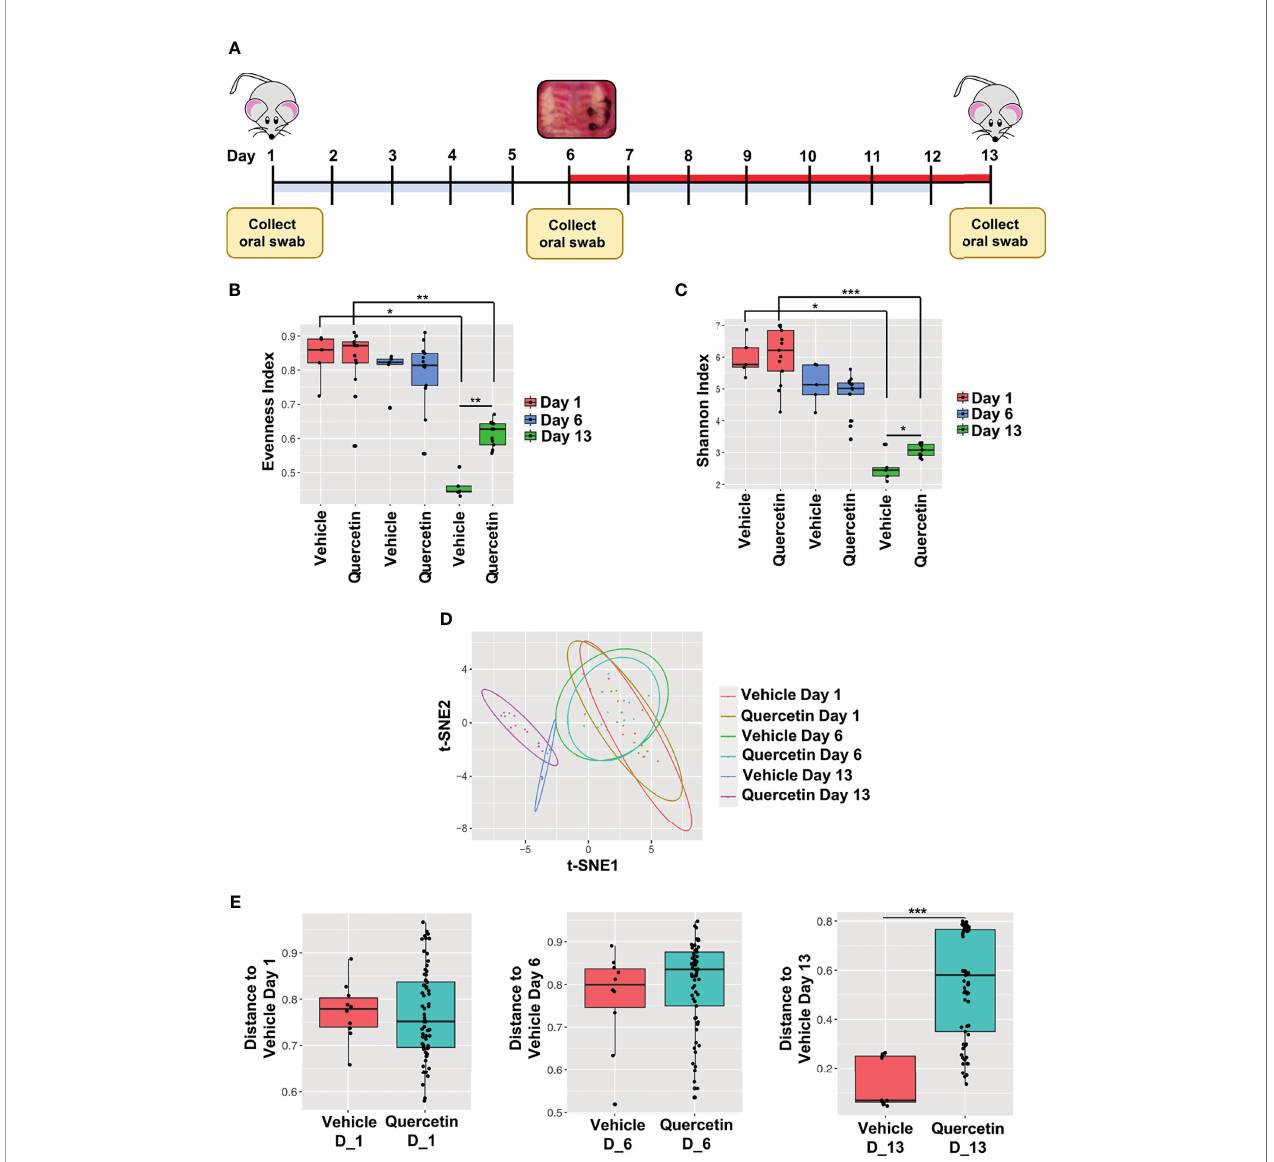
FIGURE 2 | Quercetin Treatment Increases Bacterial Diversity in Mice with Experimental Periodontitis. (A) Schematic diagram illustrating the periodontal induction and treatment experimental design and timeline of oral swab collection for subsequent 16S rRNA sequencing microbiome analysis. (B, C) Alpha diversity was assessed in the oral microbiota of 5 vehicle- and 13 Quercetin-treated mice before and after the induction of periodontitis and the Evenness (B) and Shannon index (C) of vehicle- and Quercetin-treated mice on Day 1, 6 and 13 are shown. *p ≤ 0.05, **p ≤ 0.01. (D, E) Dissimilarity was assessed in the oral microbiota of 5 vehicle- and 13 Quercetin-treated mice before and after periodontitis induction and the ordination is shown by the t-Distributed Stochastic Neighbor Embedding (t-SNE) plot (D) . The Bray-Curtis dissimilarity between vehicle- and Quercetin-treated mice in Days 1 (left), 6 (middle) and 13 (right) are shown (E) . ***p ≤